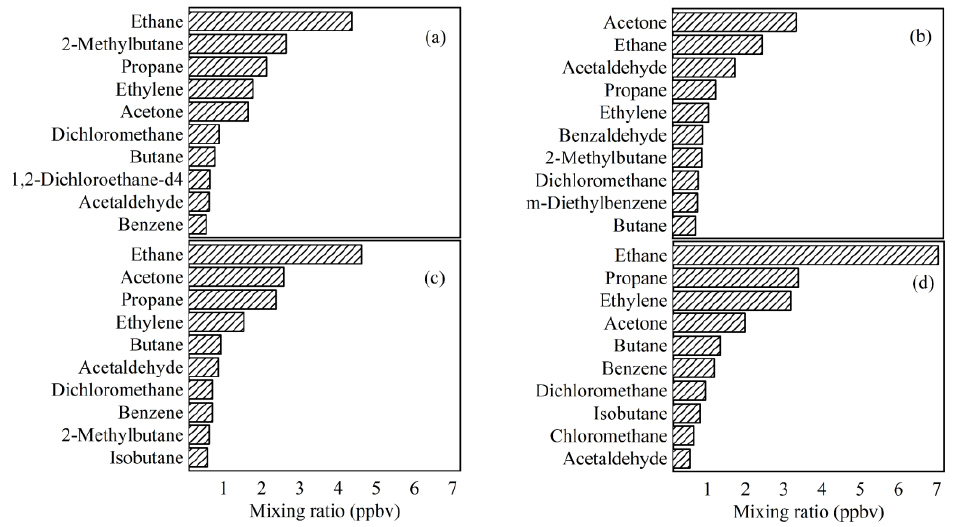
Figure 4. Top ten species of VOCs in ( a ) spring, ( b ) summer, ( c ) fall, and ( d ) winter.